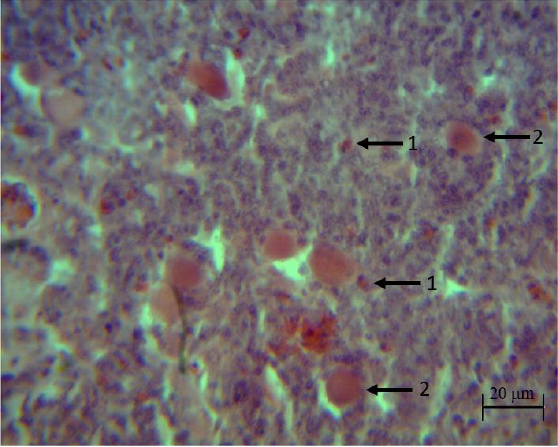
Figure 4. Histopathological injuries in the thymus of broilers challenged with S. typhimurium and C. perfringens (100X). (1) heterophiles (2) reticular epithelial cells ( S. typhimurium + C. perfringens)